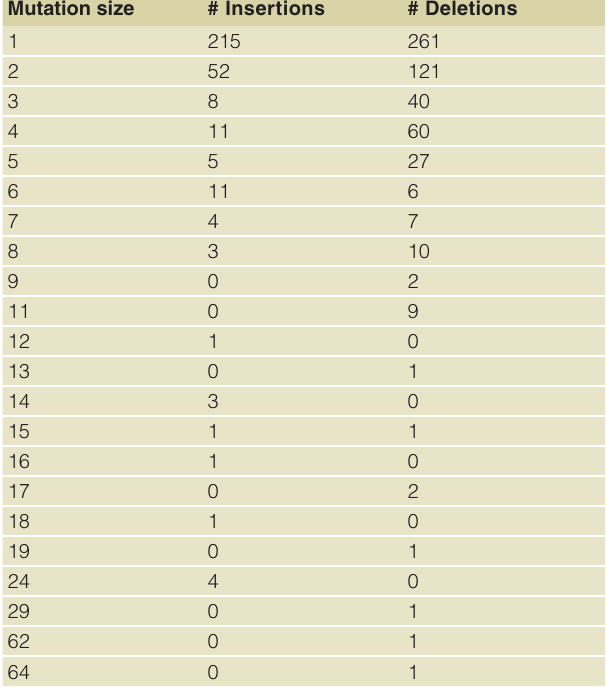
Table 1. Range of INDEL sizes (in base pairs) in the BRCA1 mutation panel. A representative range of SNPs and small INDELs corresponding to known mutations were distributed between 67 groups of simulated Illumina reads in order to test the aligners’ abilities to facilitate accurate downstream detection of mutations.